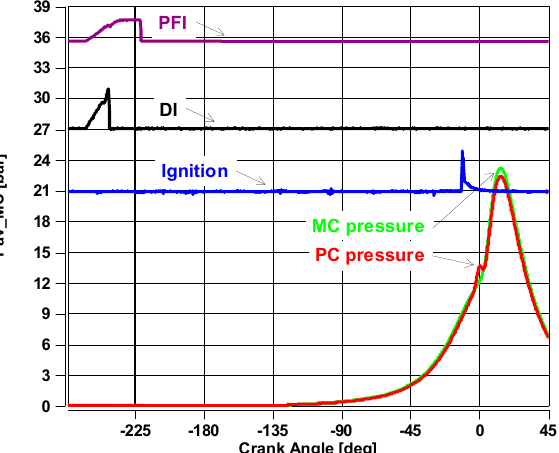
Figure 7. The fuel supply parameters relative to the ignition time and the combustion process.